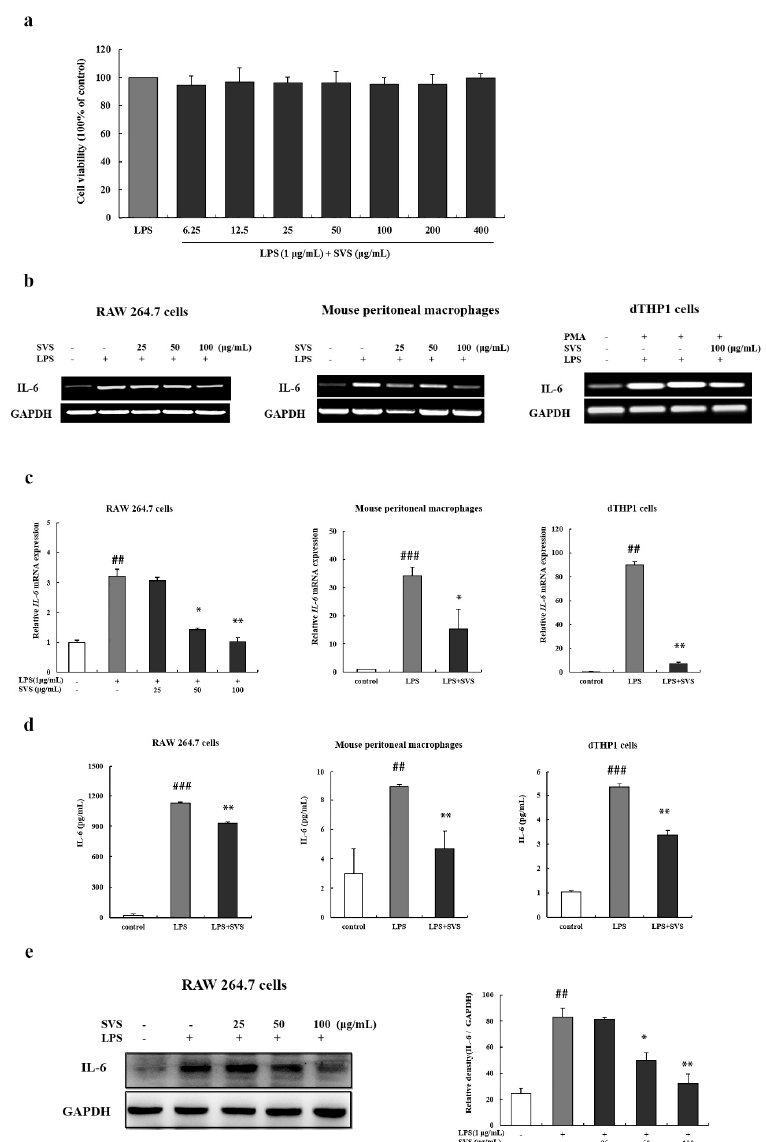
Figure 1. Stevioside inhibited IL-6 expression in lipopolysaccharide (LPS)-induced macrophages. ( a ) Effect of stevioside on the viability of RAW 264.7 cells. Cells were treated with or without stevioside at 0, 6.25, 12.5, 25, 50, 100, 200, and 400 µ g/mL with LPS (1 µ g/mL). At 24 h post-treatment, 20 µ L MTT was added to each well for an additional 4 h of incubation. Cell viability was expressed as a percentage of the control; ( b , c ) Macrophages were pretreated with or without stevioside (25, 50, or 100 µ g/mL) for 1 h and then stimulated with LPS (1 µ g/mL) for 9 h. RT-PCR ( b ) and RT-qPCR analysis ( c ) were used to detect and quantify IL-6 transcripts; ( d ) Macrophages were pretreated with or without stevioside (100 µ g/mL) for 1 h followed by LPS (1 µ g/mL) stimulation for another 24 h. IL-6 levels in the culture supernatant were determined by ELISA; ( e ) RAW 264.7 cells were pretreated with or without stevioside (25, 50, or 100 µ g/mL) for 1 h and then stimulated with LPS (1 µ g/mL) for 12 h. IL-6 expression was detected by Western blot. GAPDH was used as an internal control. Quantification of IL-6 levels is shown in the left panel, as measured by image J. Experiments were repeated three times. ## p < 0.01, ### p < 0.001 versus control group; * p < 0.05; ** p < 0.01 versus LPS-treated group. SVS,